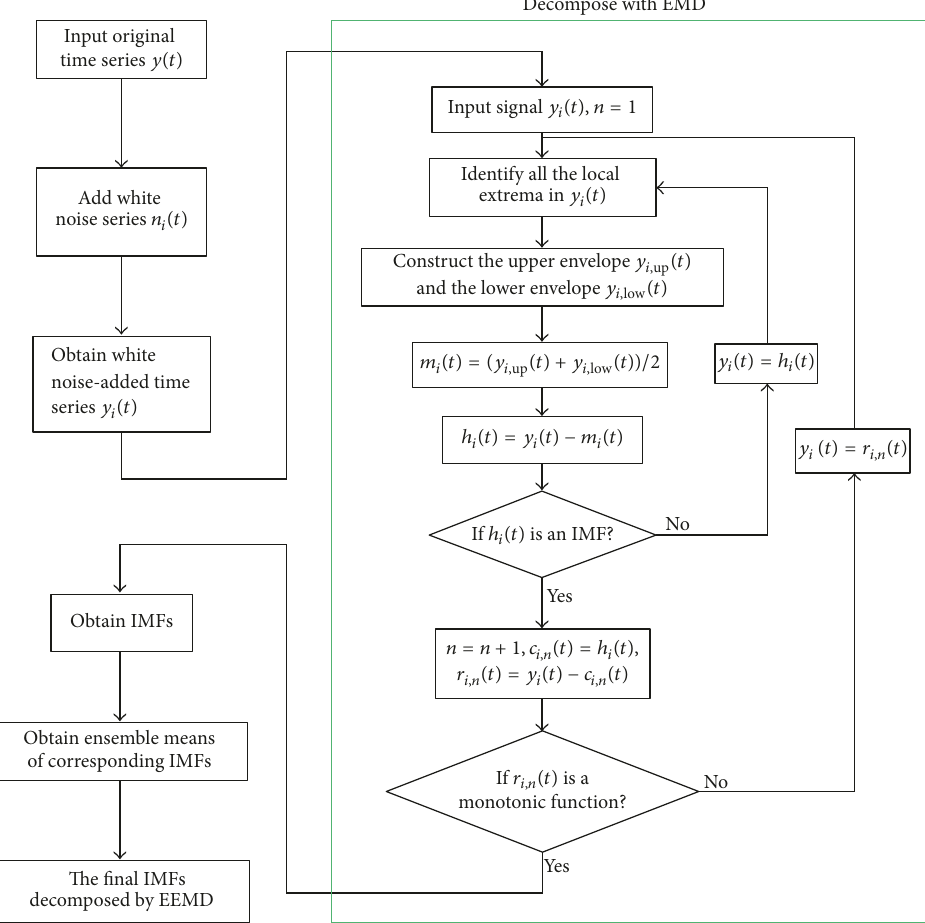
Figure 1: The flowchart of EEMD